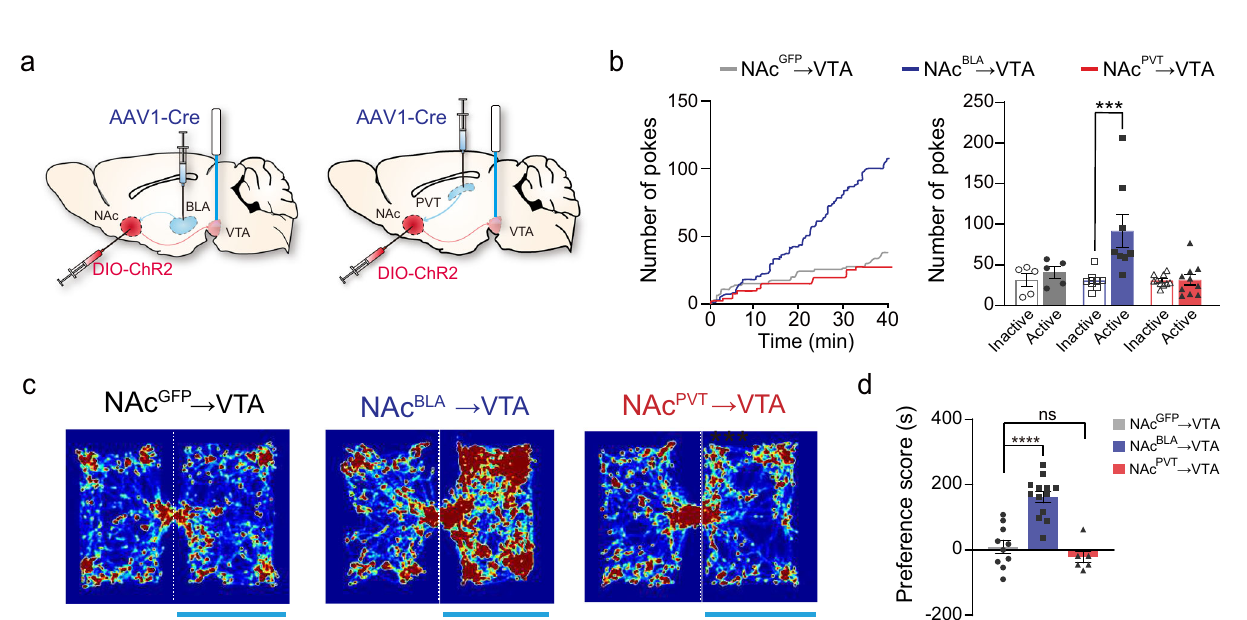
terminal in VTA slice. d Example traces showing inhibitory postsynaptic current (IPSC) recorded from VTA neurons following brief optical stimulation of NAc BLA (up) and NAc PVT (bottom) terminals, with or without the presence of picrotoxin (100mM). Scale bar: 20pA, 100ms. e Probability of synaptic connection between VTA neurons withNAc BLA neurons ( n =19 from three mice) and NAc PVT ( n =20from three mice) neurons. f Average amplitude of IPSCs from NAc BLA → VTA ( n =11) and NAc PVT → VTA ( n =2) stimulation.